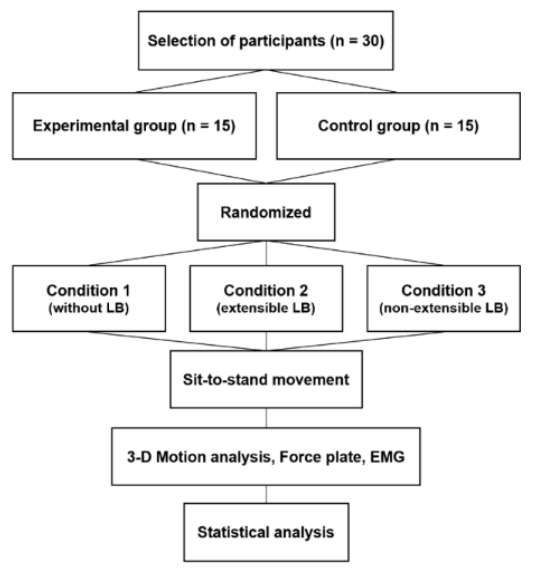
Figure 1. Experimental preparation posture.